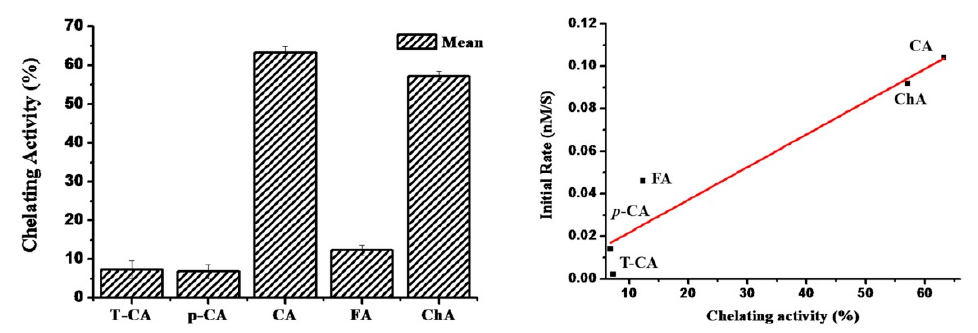
Figure 6. Chelating activity of cinnamic acid derivatives on ferrous ion. Vertical bars represent the standard error from means of three separate